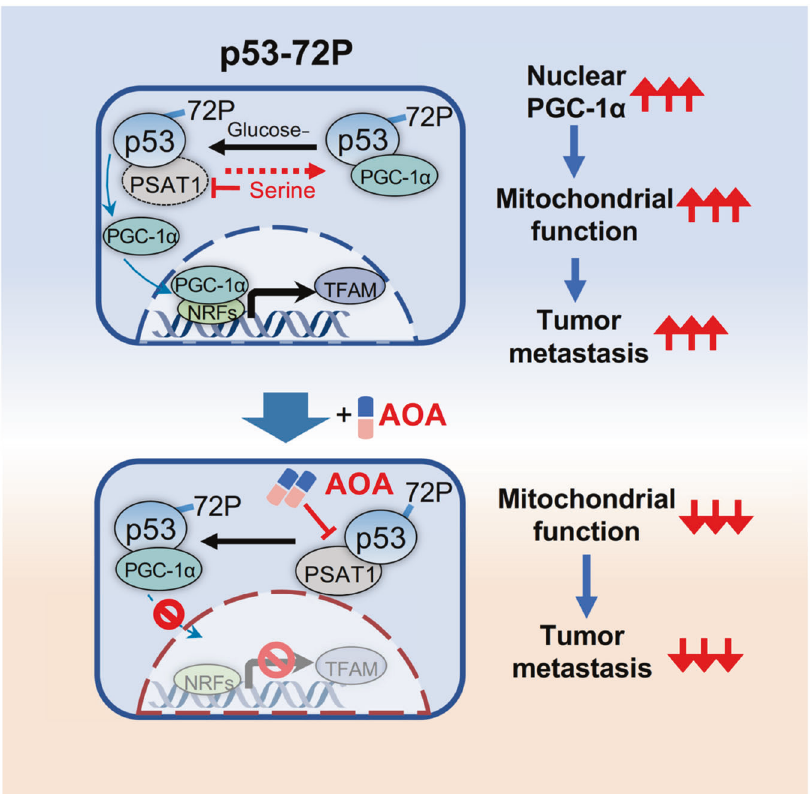
Fig. 7 A schematic model illustrating the molecular mechanism of metabolic reprogramming and therapeutic strategies in patients harboring p53 72P . PSAT1 interacts with p53-72P. Glucose deprivation enhances this interaction and leads to the dissociation of PGC-1 α from p53-72P and subsequent nuclear translocation of PGC-1 α , which promotes mitochondrial function and tumor metastasis. Interfering with PSAT1 by serine supplementation or AOA treatment can inhibit the interaction of PSAT1 and p53-72P, leading to decreased nuclear translocation of PGC-1 α and impaired mitochondrial function and tumor